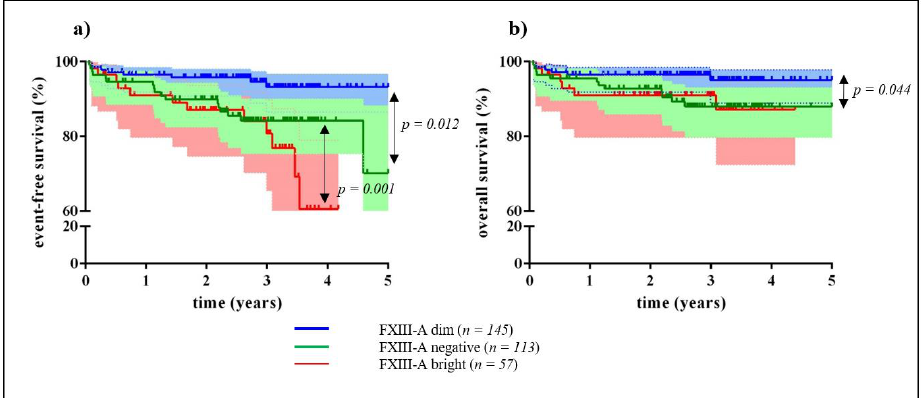
Figure 3. Event-free and overall survival of children with B-cell precursor acute lymphoblastic leukemia (ALL) by FXIII-A expression pattern. According to the Kaplan-Meier analysis, patients with FXIII-A dim lymphoblasts (blue line) had significantly higher 5-year event-free survival (EFS) (93%) compared with patients with FXIII-A bright lymphoblasts (red line; 61%) and with FXIII-A negative lymphoblasts (green line; 70%) ( a ). Mean follow-up time for the FXIII dim group was 1736 days (95% CI: 1675 and 1796 days); for the FXIII-A bright group 1277 days (95% CI: 1153 and 1400 days); and for the FXIII-A negative group 1588 days (95% CI: 1484 and 1692 days), with the last censored event at 31 days. Difference of 5-year OS was significant between patients with FXIII-A dim lymphoblasts (blue line; 95%) and patients with FXIII-A negative lymphoblasts (green line; 88%). Difference between the 5-year OS of the FXIII-A dim group and the FXIII-A bright group (red line; 87%) was not significant ( b ). Mean follow-up time for the FXIII-A dim group was 1755 days (95% CI: 1699 and 1810 days); for the FXIII-A bright group 1454 days (95% CI: 1341 and 1567 days); and for the FXIII-A negative group 1661 days (95% CI: 1572 and 1749 days), with the last censored event at 31 days. Statistically significant differences between the respective groups are marked with arrows ( a , b ). Shaded regions indicate that at any time point, there is a 95% chance that the interval contains the true percentage survival.